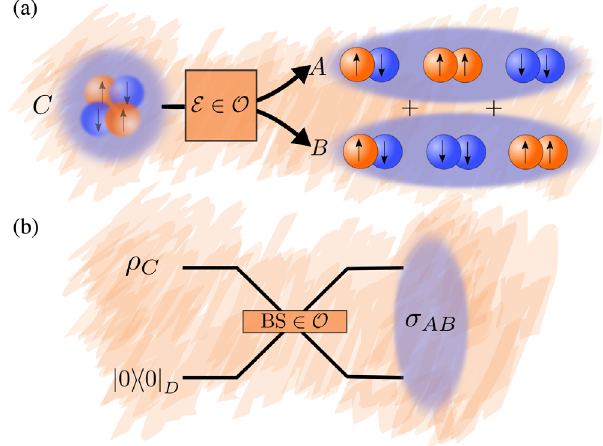
FIG. 1. (a) Conversion protocol between PE and SSR entangle- ment via the quantum operation E ∈ O . The operation E converts a system of identical particles with PE into a bipartite state, whose SSR entanglement can be extracted and utilized in quantum information tasks. The above diagram depicts the transformation E ∈ O j 2 ; 2 i ðj 1 ; 1 i j 1 ; 1 i þ j 2 ; 0 i j 0 ; 2 i þ j 0 ; 2 i j 2 ; 0 i Þ , hav- C ! A B A B A B 2 . (b) An example of a particle- N ing postselected N A ¼ B ¼ separable operation is the action of a beam splitter (BS) with a vacuum, which can be used to activate the PE present in the state ρ C